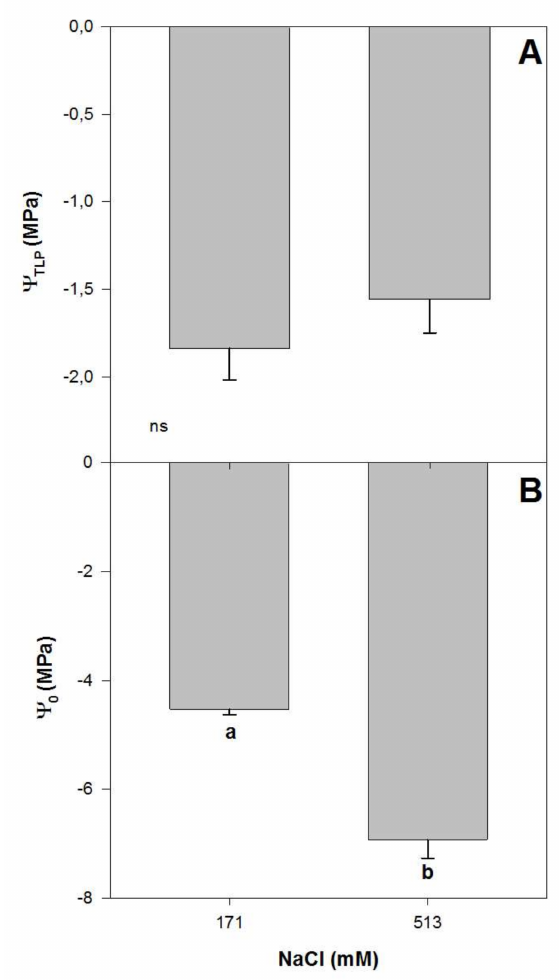
Figure 3. Water potential for turgor loss point, Ψ TLP ( A ) and osmotic potential, Ψ 0 ( B ) in randomly selected primary leaves of Atriplex halimus L. in response to treatment with two NaCl concentrations (171 and 513 mM) after 60 d of treatment. Values represent mean ± SE, n = 5. Di ff erent letters indicate means that are significantly di ff erent from each other (ANOVA test, p < 0.05) and ns indicates non-significant di ff